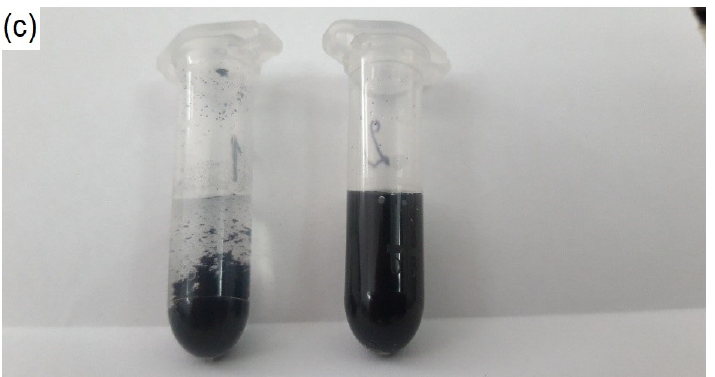
Figure 3. SEM morphological details of CNTs as received from the manufacturer, before ( a ) and after ( b ) loading with the mixture CHX/AgNPs (High magnification, 100,000×); ( c ) photographic image of colloidal CNTs in distilled water (left) compared to colloidal mixture CHX/AgNPs (right). After blending the components and waiting for the setting time, according to the manufacturer’s instructions, SEM images were recorded on the fractured surface of neat and modified sealer, without any other surface preparation, as presented in Figure 4.